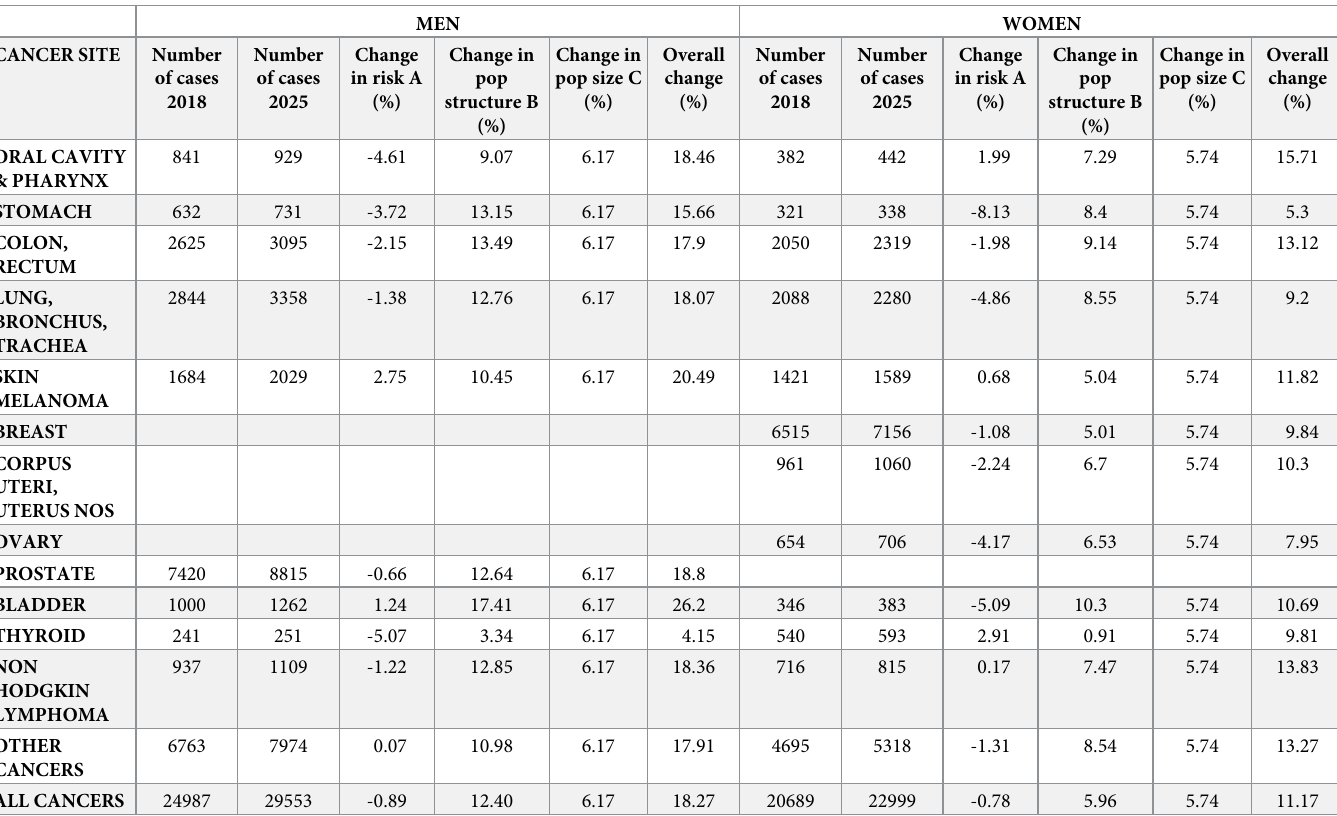
Table 1. Estimated numbers of cancer cases for 2018 and predictions for 2025 in Switzerland by cancer site and by sex. Overall predicted changes are factorized (mul- tiplicatively) into changes in standardized risk (A), in population structure (B), and in population size (C) (Eq (4)). MEN